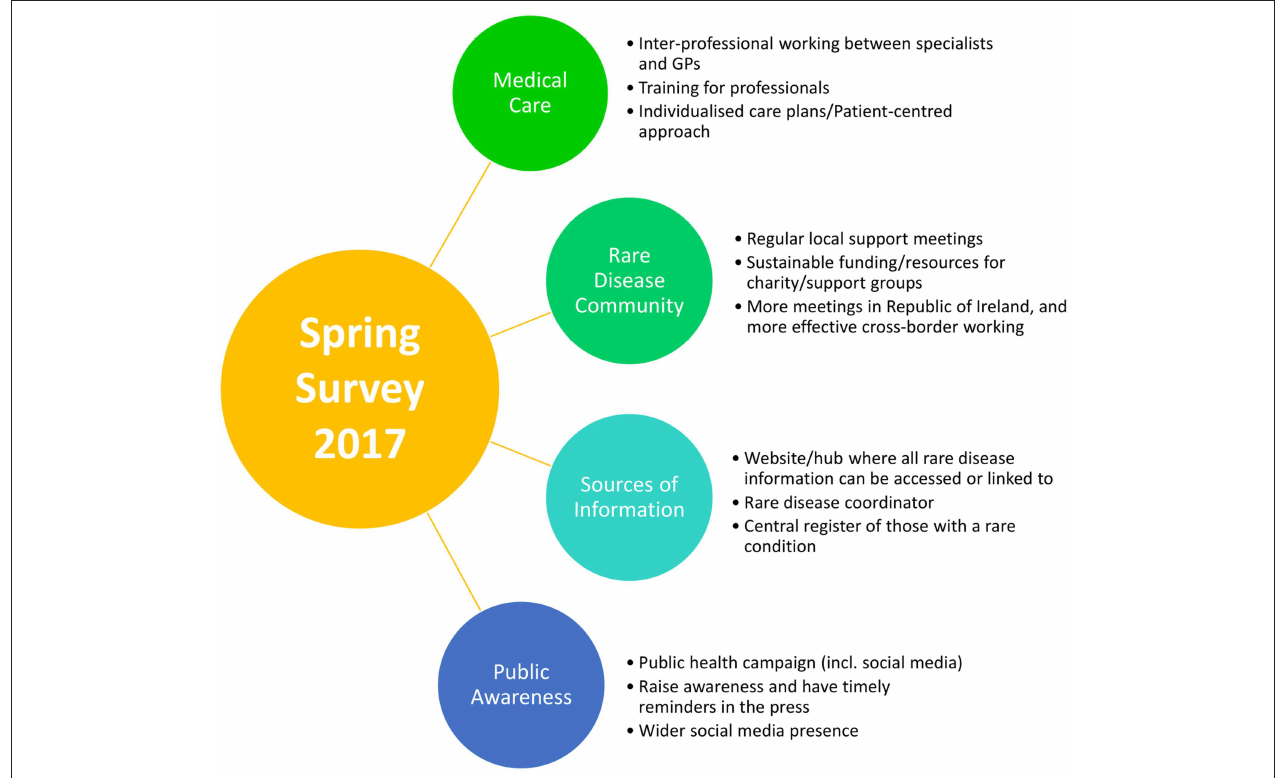
FIGURE 6 | Priorities from thematic analysis of the information and communication survey